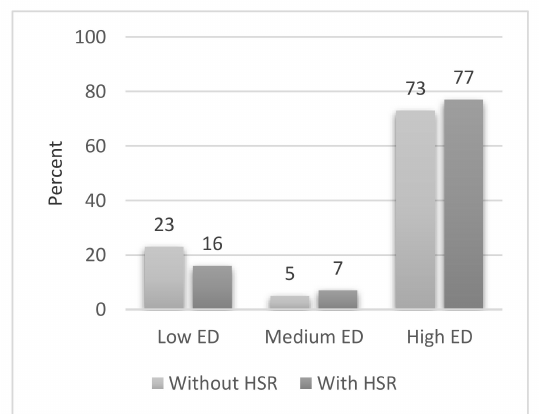
Figure A1. Proportions of low, medium and high energy density (ED) products without and with a Health Star Rating